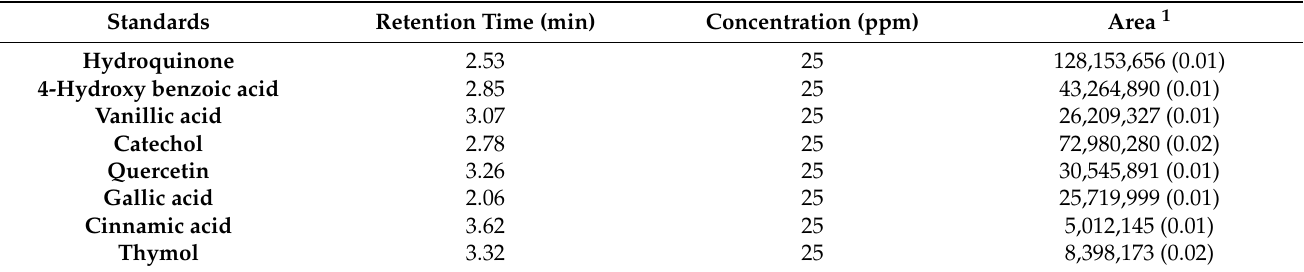
Table 4. Standards of phenolic compounds and their retention